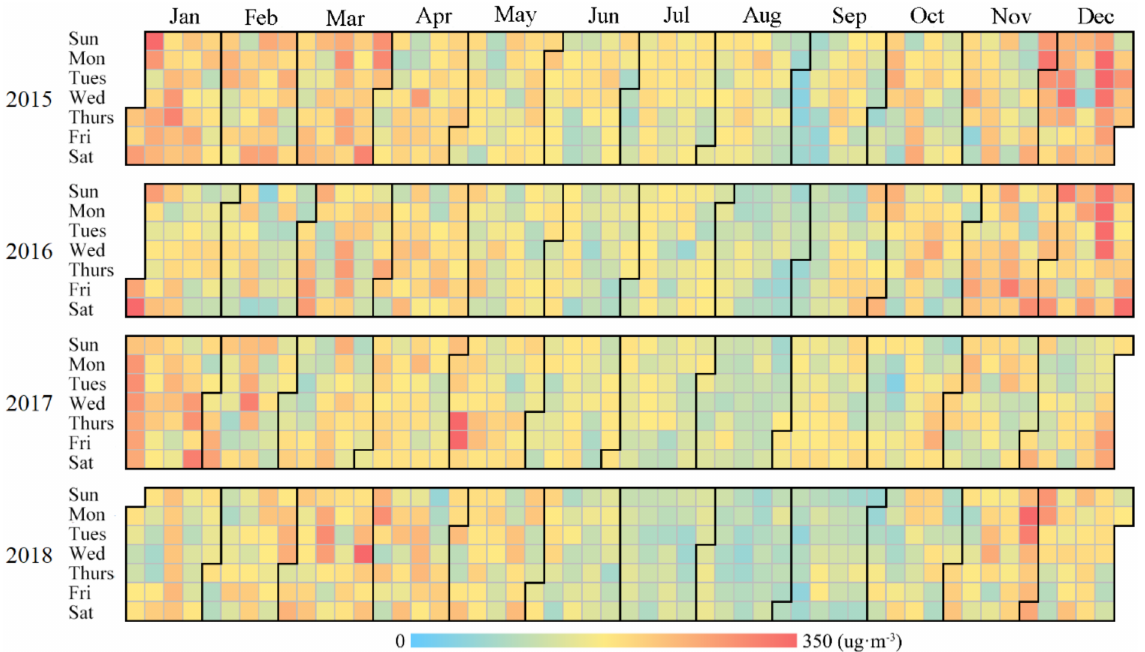
Figure 5. Thermographic calendar of daily PM 10